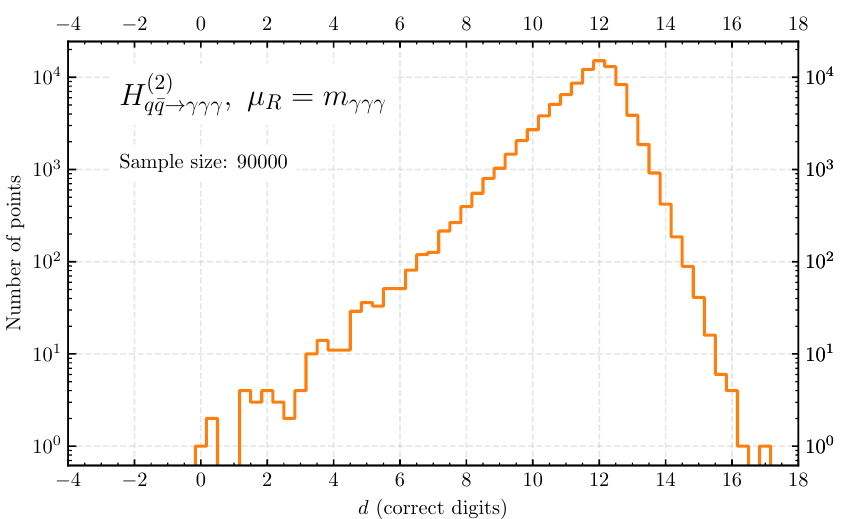
Figure 2. The logarithmic distribution of correct decimal digits (as defined in eq. (4.5)) for 90000 double-precision evaluations of the H (2) function. The phase-space points are sampled from a distribution representative of typical phenomenological